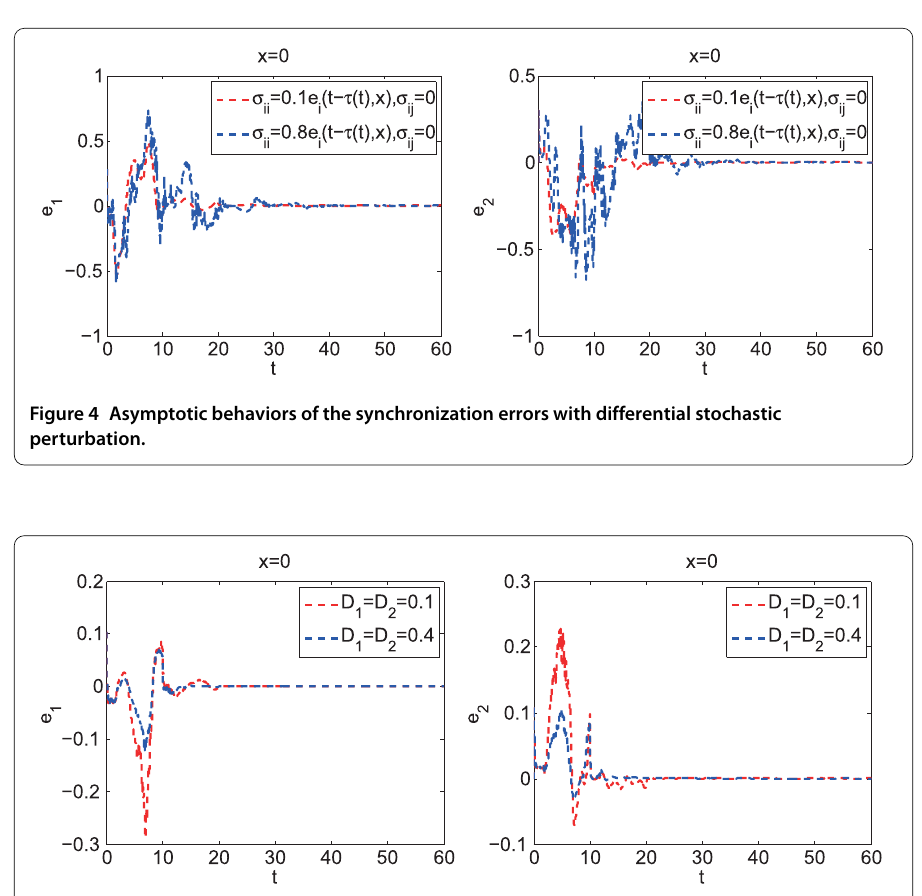
Figure 5 Asymptotic behaviors of the synchronization errors with differential diffusion coefficients.